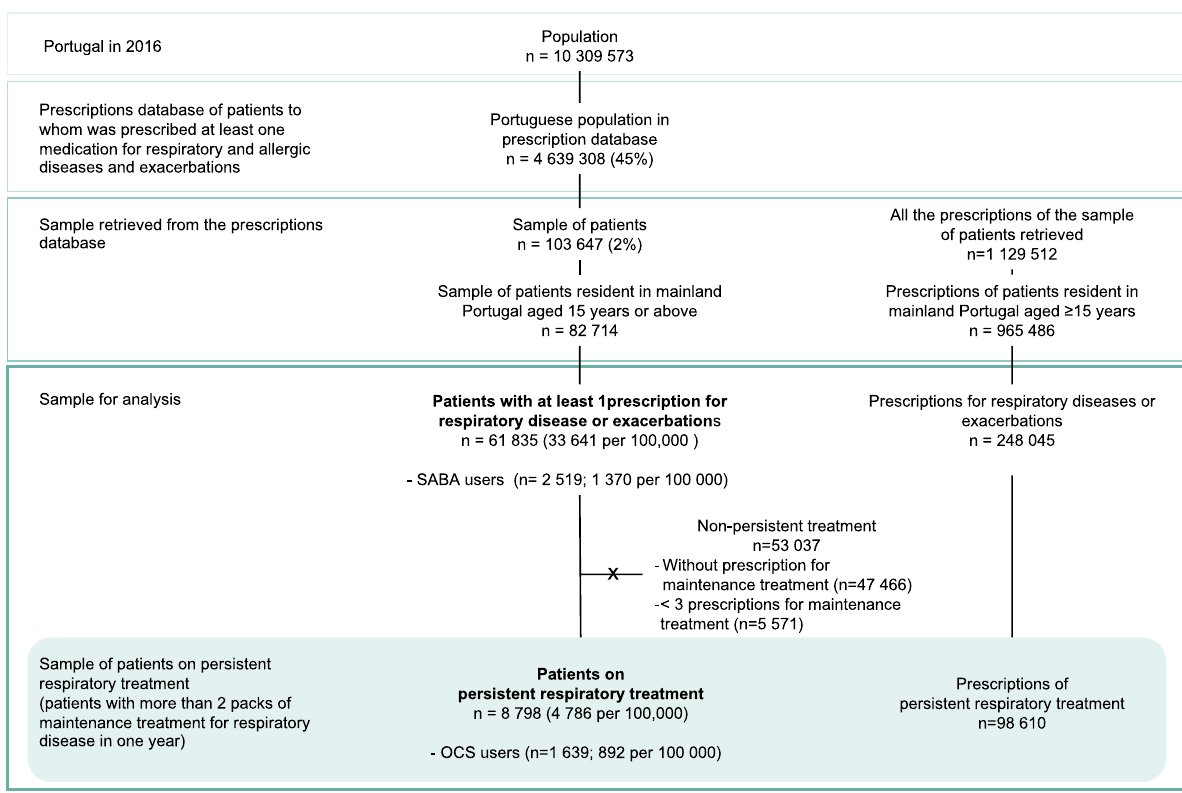
Fig. 1 Flowchart of patients for analysis. SABA short‑acting beta2 agonist, OCS oral